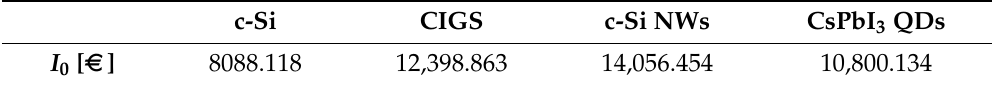
Table 3. Initial investment for different photovoltaic generators, using different